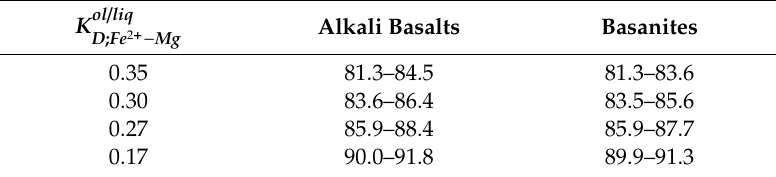
Table 3. K ol / liq values for a variety of melts with varying total alkali D ; Fe 2 + − Mg